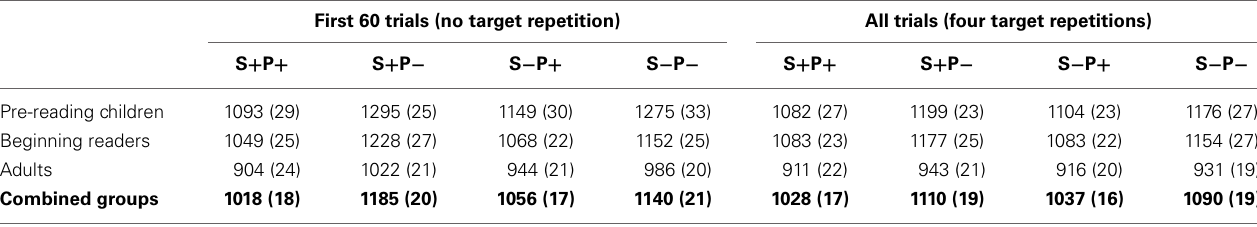
Table 2 | Mean reaction times in milliseconds (and standard error of mean) are shown for each group and each condition First 60 trials (no target repetition)